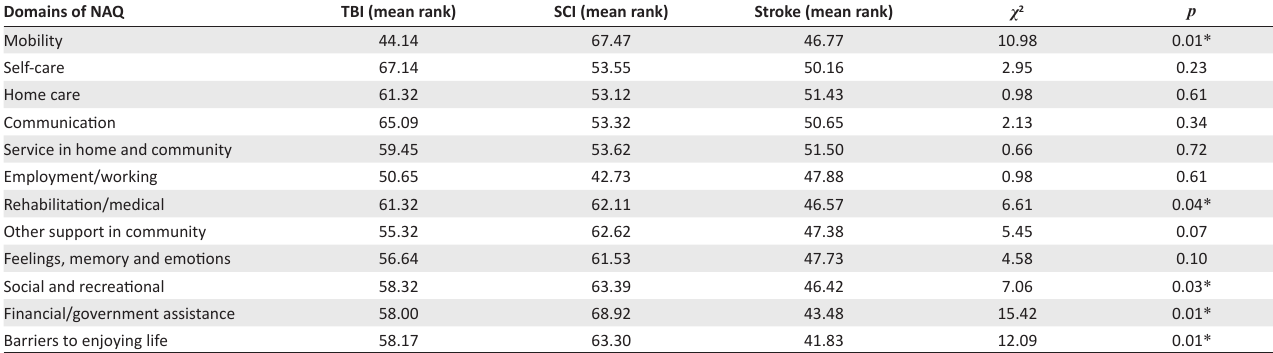
TABLE 3: Differences in rehabilitation needs (as scored by modified Needs Assessment Questionnaire) across neurological conditions ( n = 105). Domains of NAQ